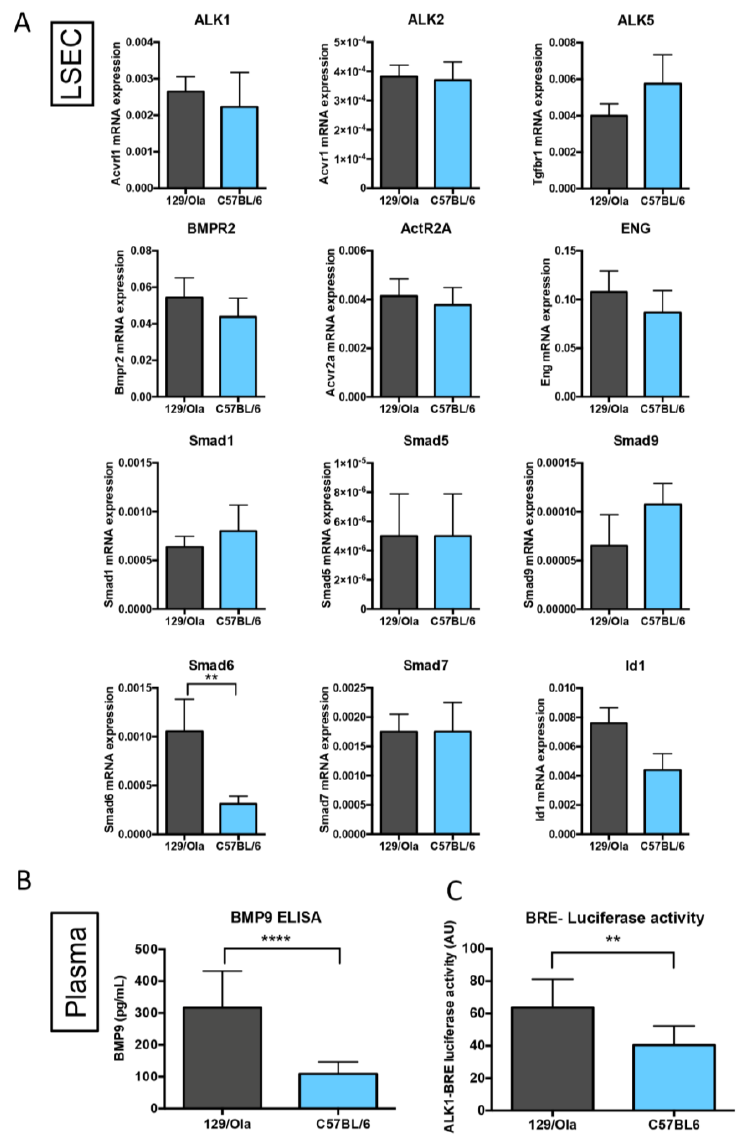
Figure 5. BMP9 / ALK1 signaling pathway in 129 / Ola and the C57BL / 6 WT mice. ( A ) Quantification of the mRNA expression level of type I (ALK1, ALK2, ALK5) and type II (BMPR2, ActR2A) receptors,